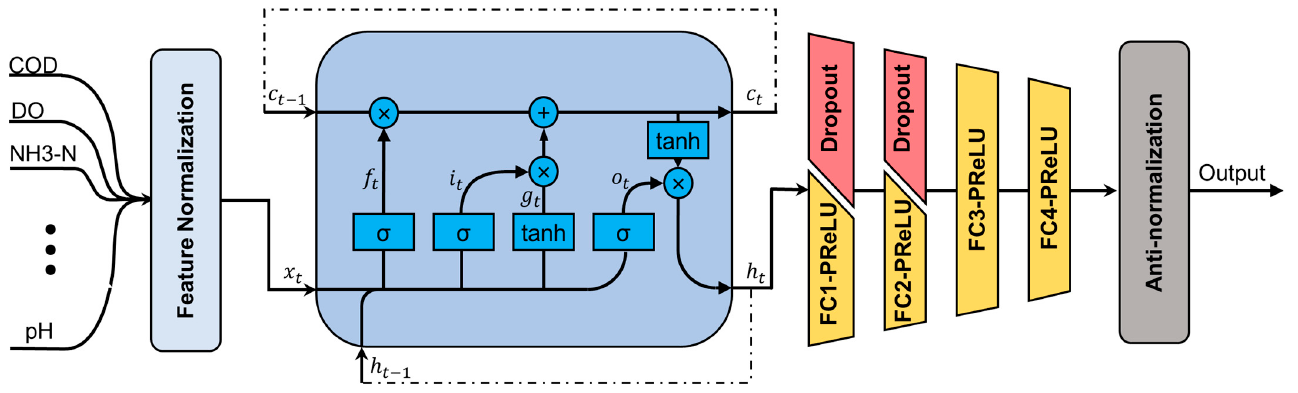
Figure 4. The structure of the LMPNet model.